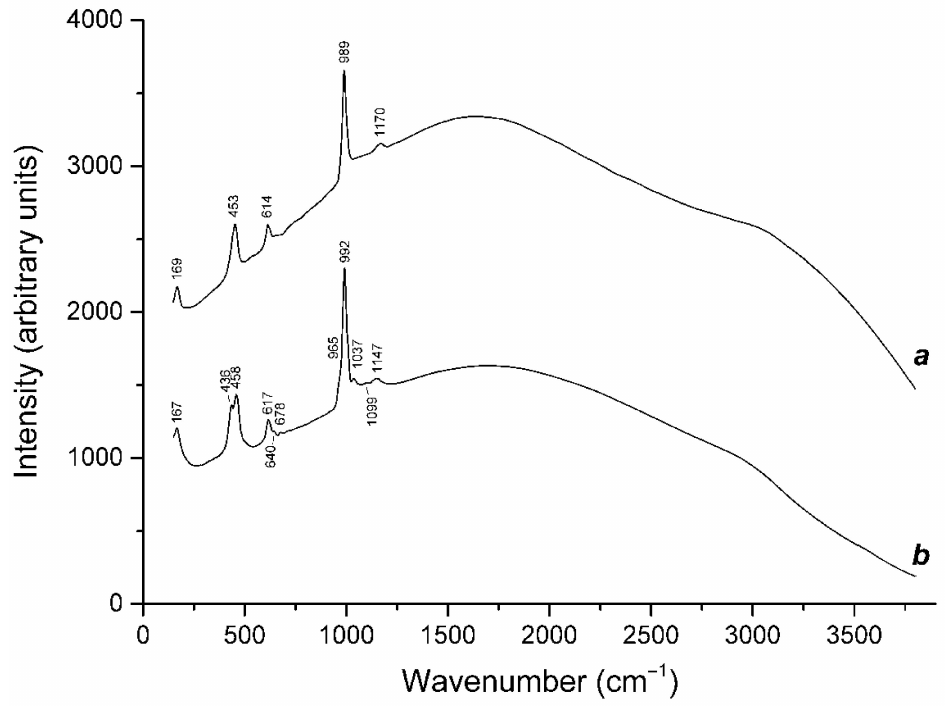
Figure 21. Raman spectra of ( a ) biachellaite (Sample 14) and ( b ) SO 32— -bearing analogue of marinel- lite (Sample